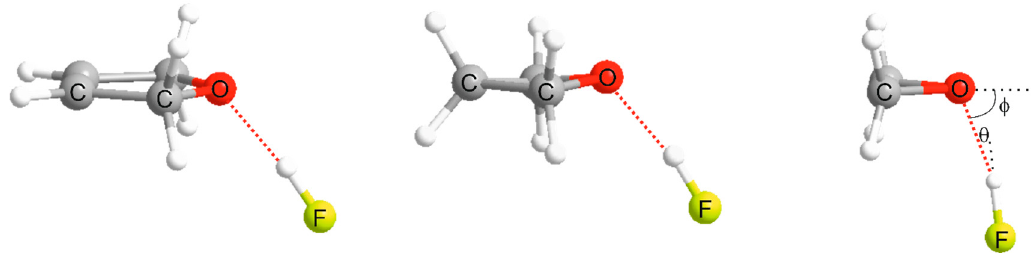
Figure 4. Equilibrium geometries of complexes of 2,5-dihydrofuran, oxetane and oxirane with HF from calculations at the CCSD(T)-F12c/cc-pVTZ-F12 level of theory. The equilibrium angle φ is indicated for the oxirane complex. The angle θ defines the deviation of the hydrogen bond nuclei O · · · H–F from collinearity.